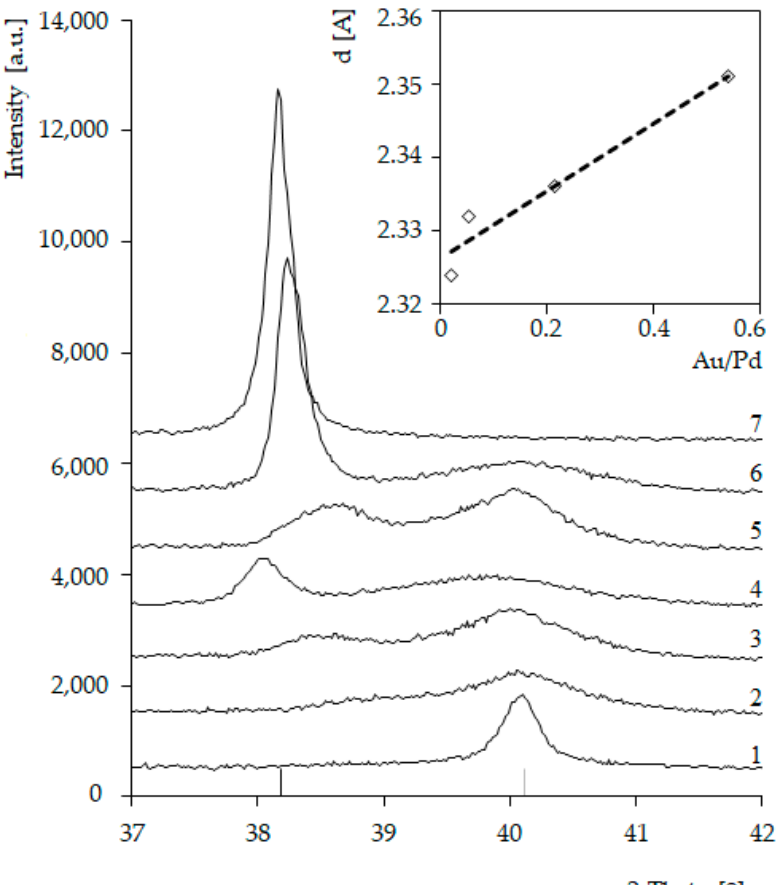
Figure 3. Diffractograms of catalysts: (1) 5%Pd/SiO 2 ; (2) 5%Pd-0.2%Au/SiO 2 ; (3) 5%Pd-0.5%Au/SiO 2 ; (4) 5%Pd-1%Au/SiO 2 ; (5) 5%Pd-2%Au/SiO 2 ; (6) 5%Pd-5%Au/SiO 2 ; (7) 5%Au/SiO 2 (activated in H 2 for 2 h at 300 °C) and linear relationship of plane distances as a function of those systems’ composition (Vegard’s rule).